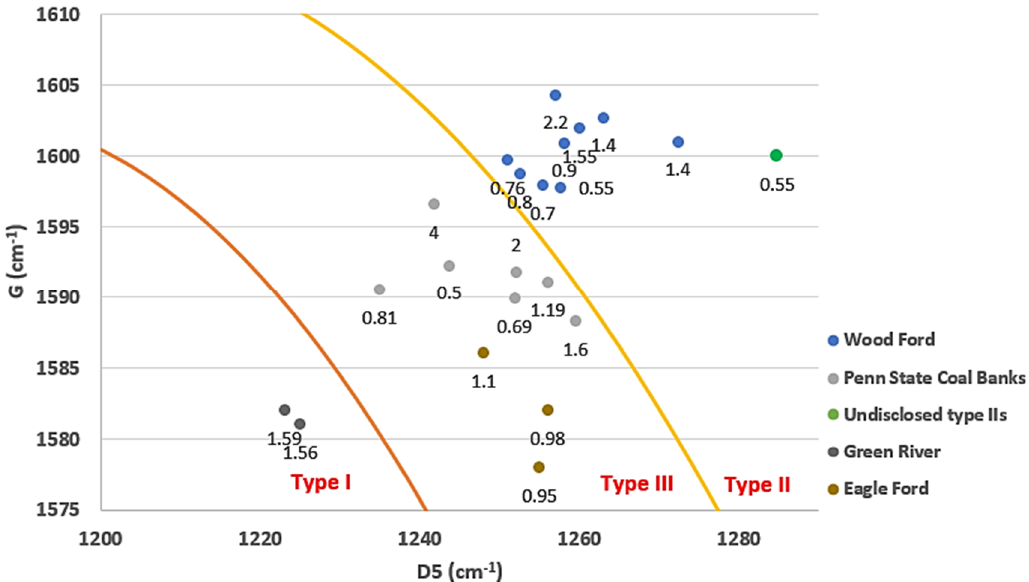
Figure 6. G vs. D5 is important for kerogen typing. As seen, different types of kerogen are located on this graph based on what is expected from their sulfur content (Type II > Type III > Type I) (numbers reflect thermal maturity of the samples). (Data are from this study acquired by the 632 nm laser wavelength).